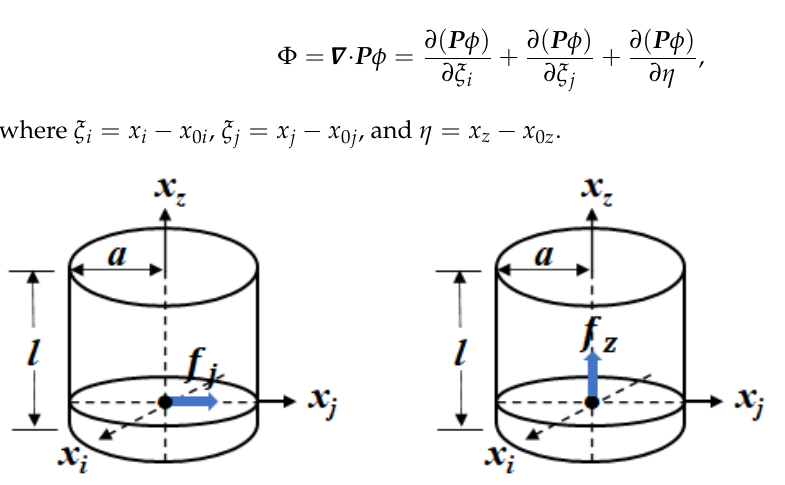
Figure 1. Two forms of the point source vector along the x j and x z directions used in analytical mod- eling.